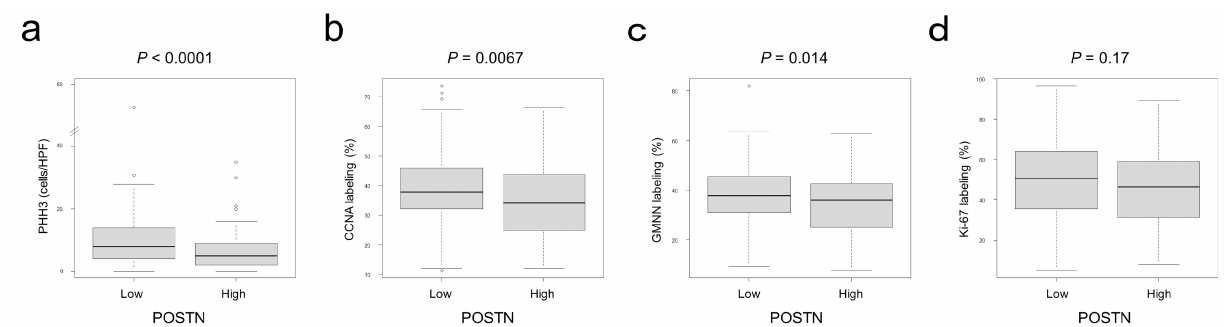
Figure 2. Correlation between stromal POSTN expression and cellular proliferation markers in CRC cells. Cellular proliferation marker expression in CRC cells classified by stromal POSTN expression. ( a ) PHH3, ( b ) CCNA, ( c ) GMNN, and ( d ) Ki-67. POSTN-positive tumors contained a significantly lower number of PHH3-, CCNA-, and GMNN-positive cells than negative tumors. The circles indicate